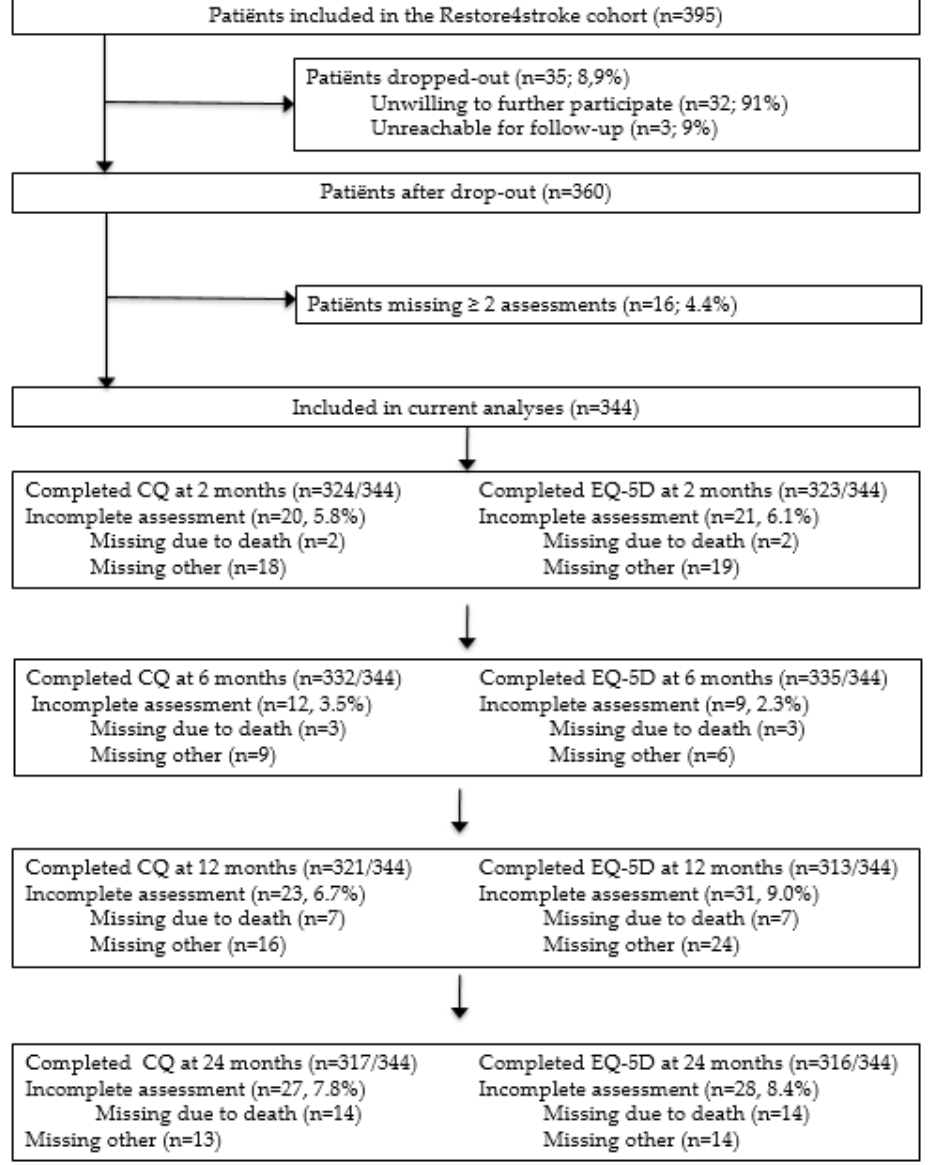
Figure 1. Flowchart for patient inclusion and missing data. Abbreviations: CQ—cost questionnaire; EQ-5D—three-level EuroQoL